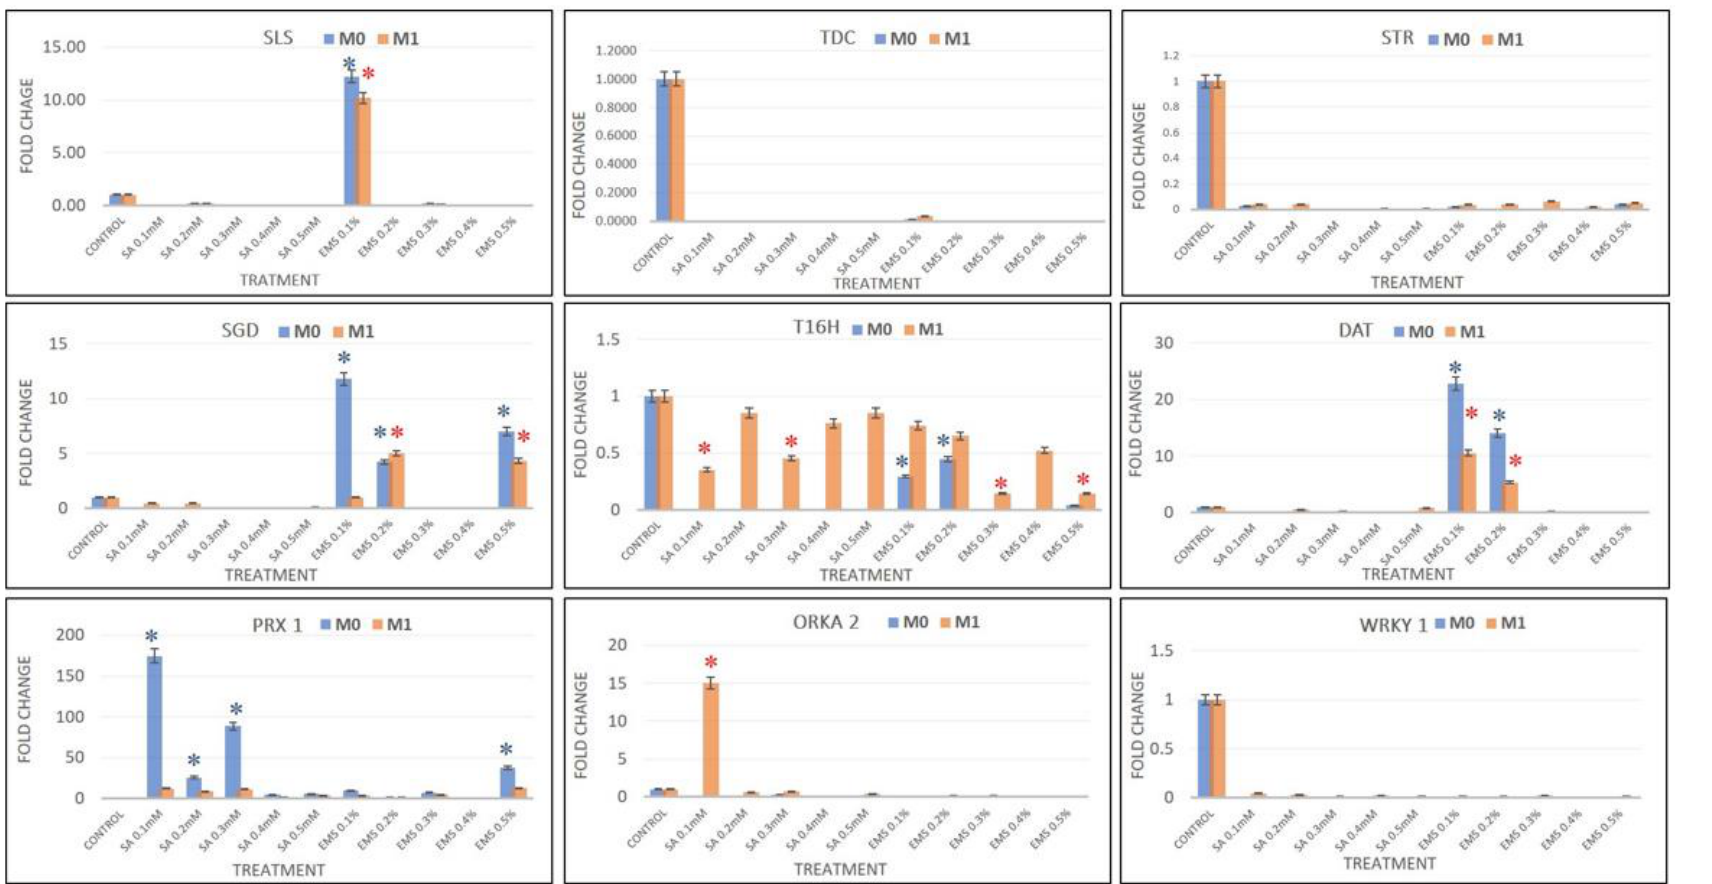
Figure 7. Real-time PCR quantification of the key MIA pathway genes in C. roseus in different concentrations of SA- and EMS-treated and control plants. The pathway genes are represented as: SLS , secologanin synthase; TDC , tryptophan decarboxylase; STR , strictosidine synthase; SGD , strictosidine b-D-glucosidase; T16H , tabersonine 16-hydroxylase; DAT , deacetylvindoline acetyltransferase; PRX1 peroxidase, and transcription factors- ORCA2 , and WRKY1 , key regulators of the MIA pathway, were determined using Livak’s 2 − ∆∆ Ct method (along with controls). The Ct value (threshold cycle) for each gene was normalized against the Ct from C. roseus RSP9 gene. (Primer list provided in Supplementary Materials). * represents that a significant difference was observed from the respective control at p < 0.05 after applying post hoc Dunnett’s test ( n = 3).